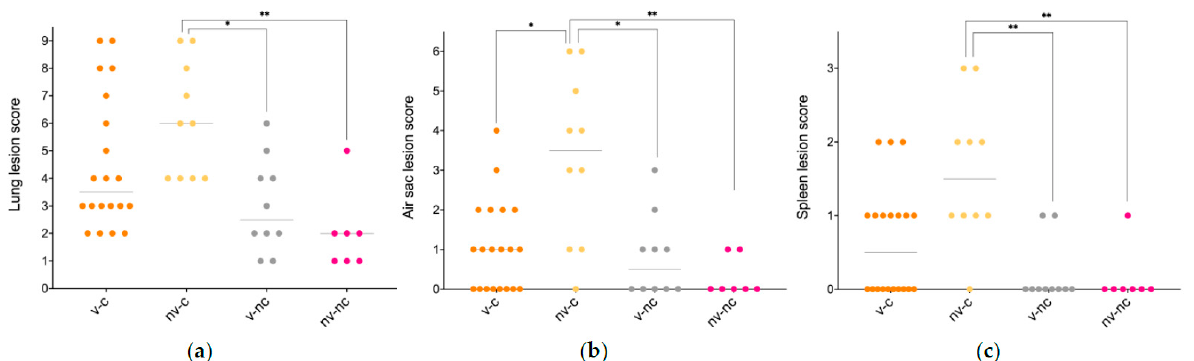
Figure 2. Histopathological scores of lesions in the lung, air sac and spleen. ( a , b ) presents the overall lung and air sac lesion score, respectively, both based upon evaluation of oedema, congestion, inflammation, and necrosis, and ( c ) exhibits the overall spleen lesion score based upon the presence of necrosis, proteinaceous fluid, and distortion of the tissue architecture. The data are presented with the median and was analysed utilising a Kruskal-Wallis test and Dunn’s multiple comparisons test. * p < 0.05, ** p < 0.01. Abbreviations: nv-c, not vaccinated-challenged; nv-nc, not vaccinated-not challenged; v-nc, vaccinated-not challenged; v-c, vaccinated-challenged.